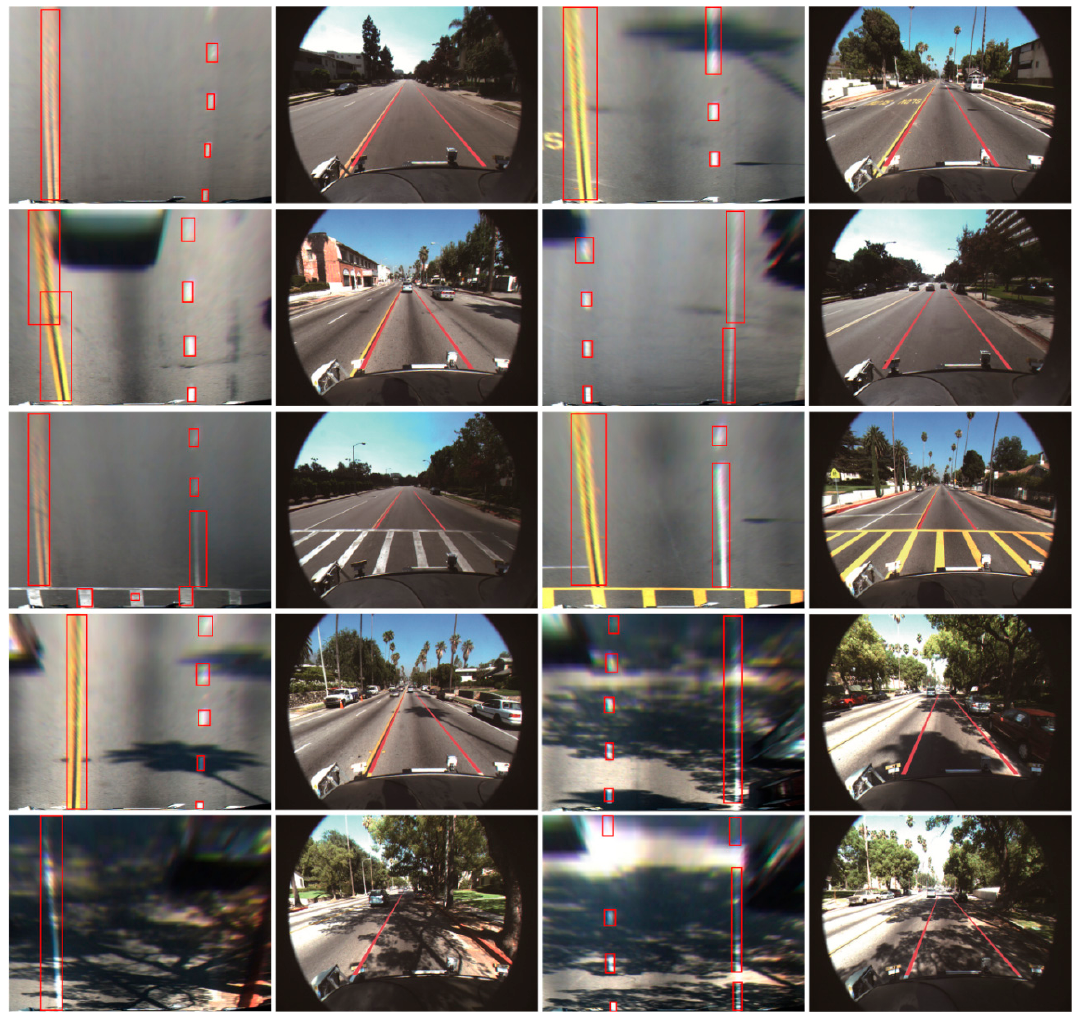
Figure 10. Fitting results after lane detection (the odd columns show the lane detection result under the bird-view perspective, and the even columns show the lane fitting result mapped to the original image).